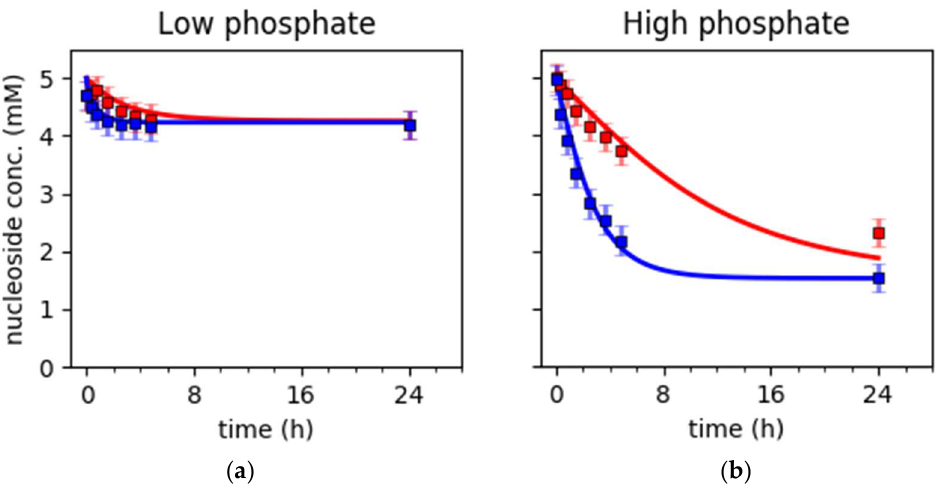
Figure 3. Exemplary fits for experimental data at low and high phosphate concentrations. ( a ) Experimental data and model predictions for conditions with low phosphate-to-deoxythymidine ratio (2 mM : 5 mM), and varying enzyme concentrations (red: High enzyme concentration, Experiment #13; blue: Low enzyme concentration, Experiment #12). Though the speed of reaction differs in the beginning, both reactions reach the same equilibrium during the time course of the experiment. Error bars represent 95% confidence intervals for the experimentally determined concentrations; ( b ) experimental data and model predictions for conditions with high phosphate-to-deoxythymidine ratio (80 mM : 5 mM), and varying enzyme concentrations (red: High enzyme concentration, Experiment #21; blue: low enzyme concentration, Experiment #20). The two conditions differ in their speed and low enzyme concentration is not sufficient to reach equilibrium. Error bars represent 95% confidence intervals for the experimentally determined concentrations. See Table S1 for experimental condition numbers as given in this figure legend (“Experiment #”).